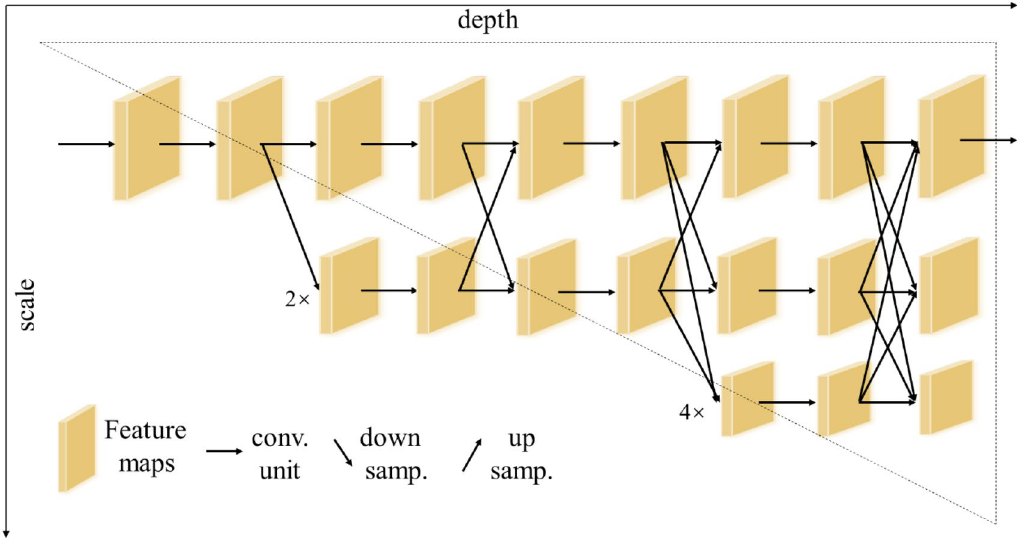
Figure 4. Architecture of the original HRNet 10